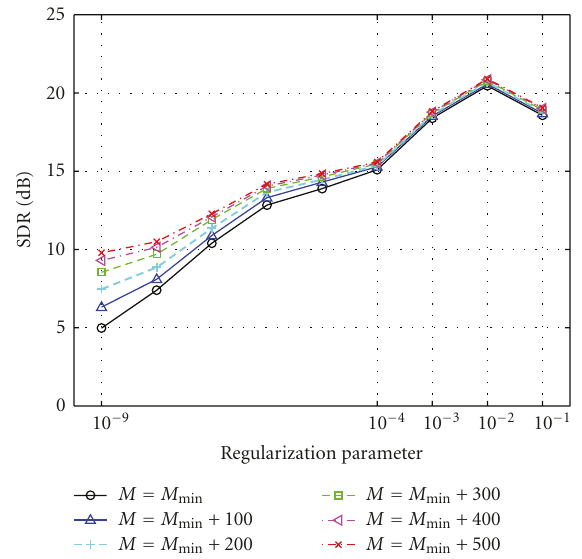
Figure 8: Performance as a function of regularization parameter and filter length with an SNR of 20dB (modeling delay is fixed at d =